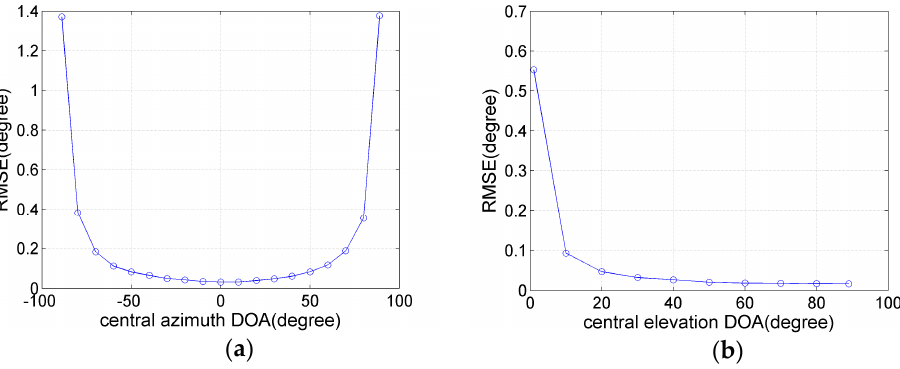
Figure 5. ( a ) RMSE curves versus the central azimuth DOA; ( b ) RMSE curves versus the central elevation DOA.